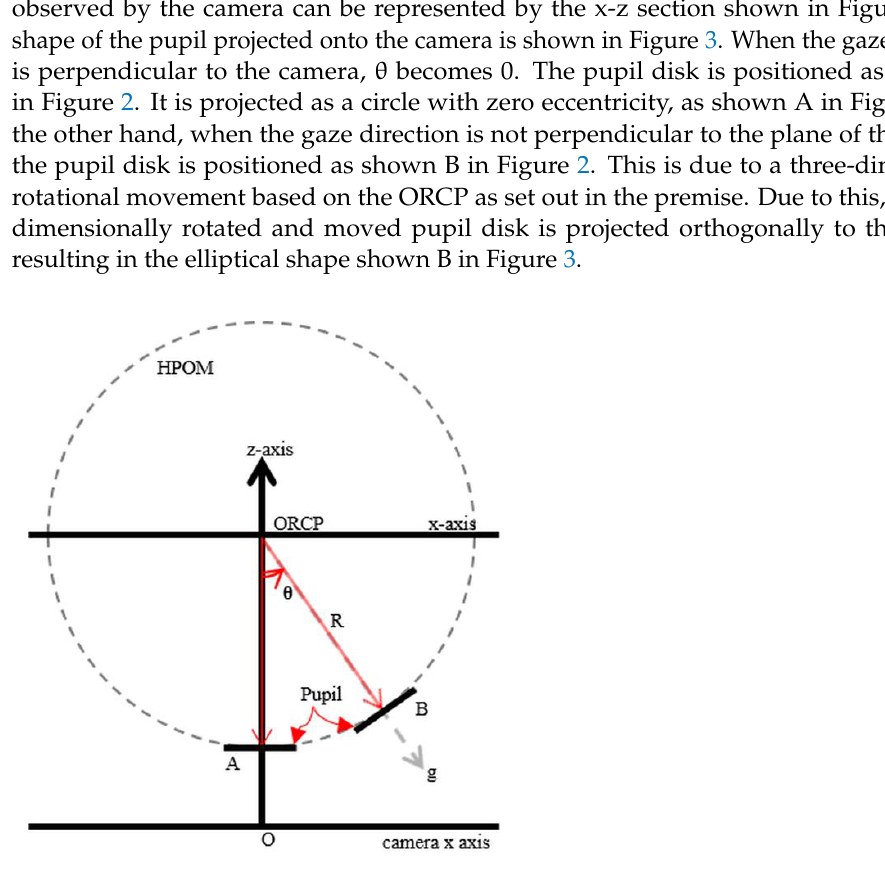
Figure 3. S hape of PPC according to ф and θ. If the gaze direction changes from position B shown in Figure 2 while θ is fixed, the PPC appears in the form of B being rotated along the z-axis relative to the ORCP, as shown C in Figure 3. Therefore, θ is the Rotation Angle of the Eye (RAE). This causes a change in the pupil’s size due to changes in the eccentricity of the PPC and a change in the distance along the z- axis. ф is the Rotation Direction Angle of the eye (RDA). This causes rotation of the PPC. In addition, it can be seen that the short axis of the elliptically-changed PPC is formed at the same angle as the RDA. 2.5. 3D Rotation of the Pupil Disc Previously, the principle that the eccentricity and rotation of the PPC changes accord- ing to the RAE and RDA using HPOM, was analysed. Based on the results of this analysis, a three-dimensional Rotation Model of a Disk (RMD) was constructed to analyse the atti- tude of the pupil in three-dimensional space. RMD is a model used to observe the three- dimensional attitude of the eye using images captured by a camera that observes changes due to the rotation along each axis of the disk in an environment where the xy-coordinate